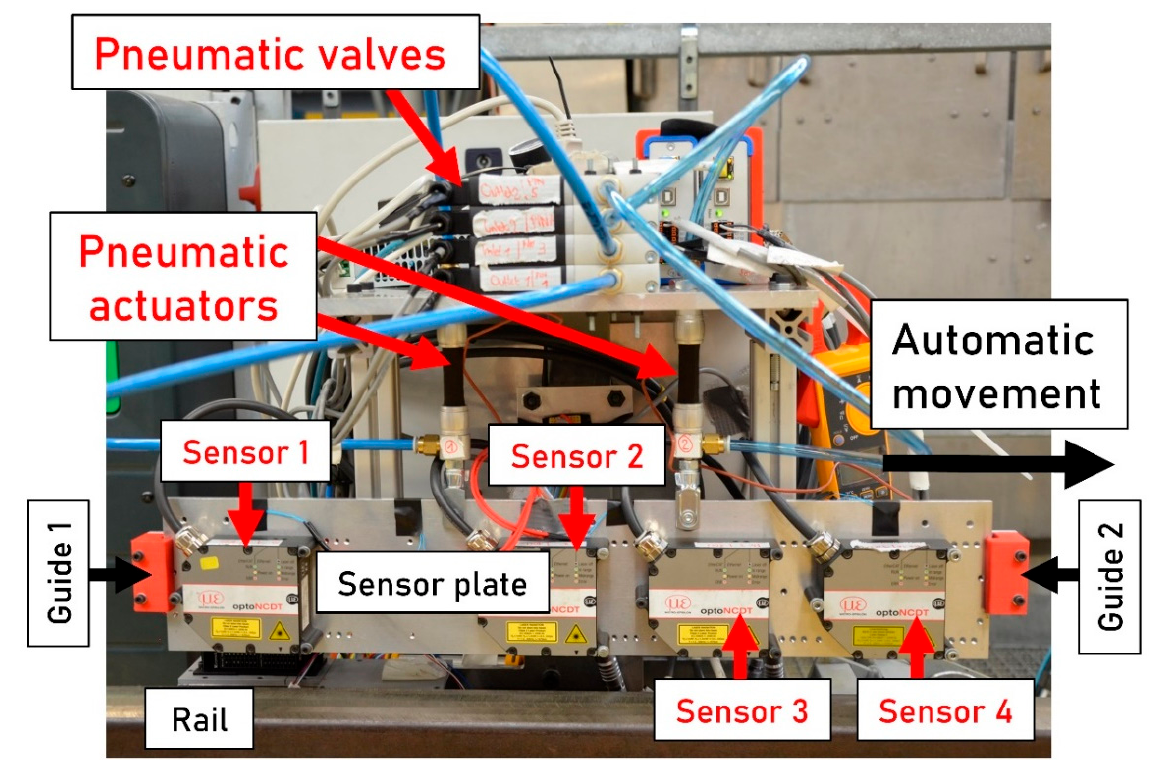
Figure 1. Test stand including sensor plate and pneumatic actuators.